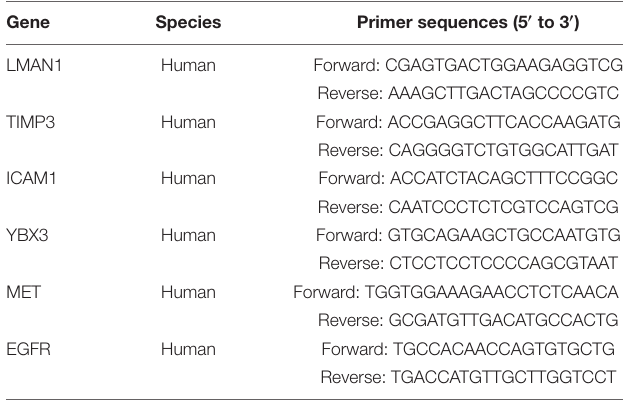
TABLE 2 | List of siRNA